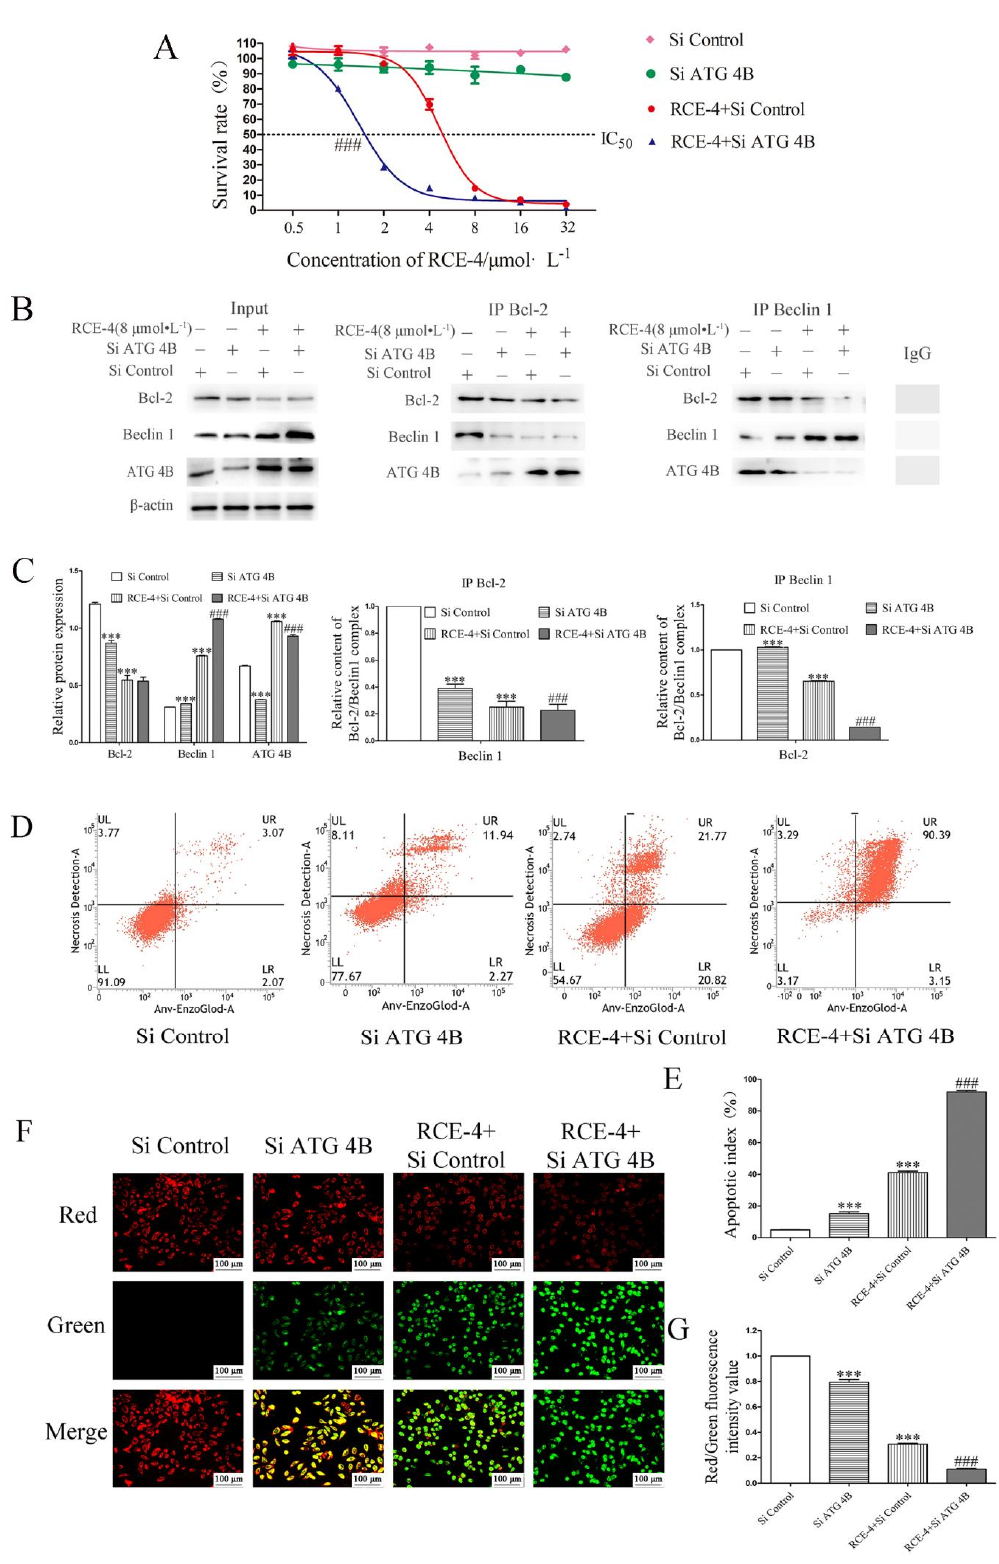
Figure 7. RCE-4 combined with ATG 4B siRNA enhanced the sensitivity of Ca Ski cells. ( A ) RCE-4 combined with or without ATG 4B siRNA inhibited the proliferation of Ca Ski cells. Data are presented as the mean ± standard deviation